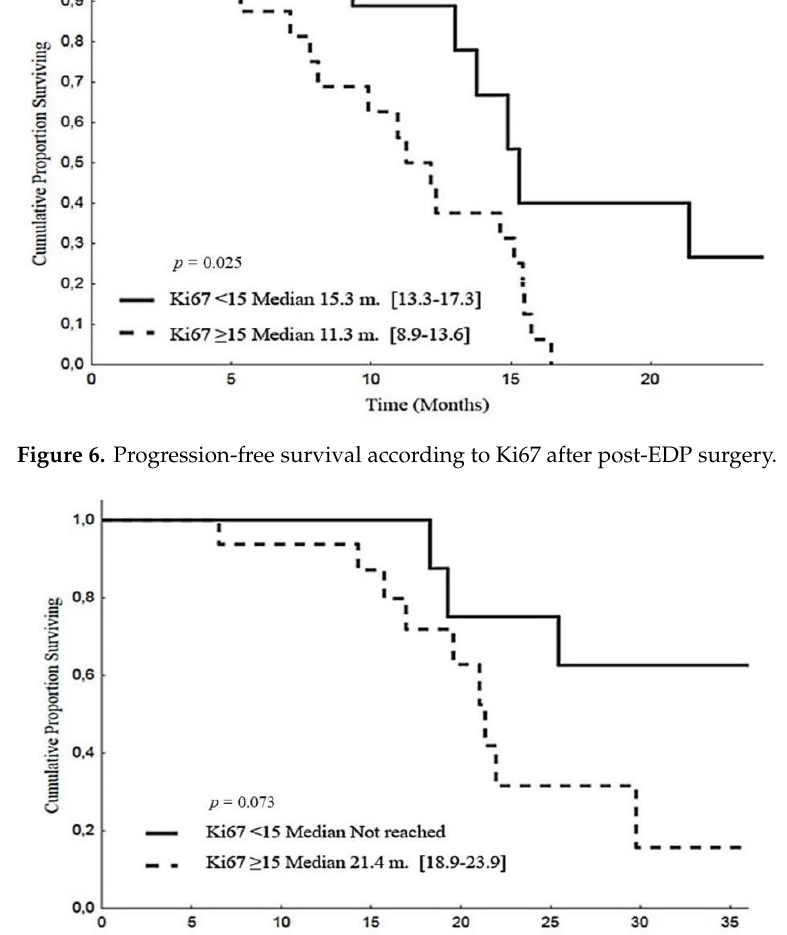
Figure 7. Overall survival according to Ki67 assessed after post-EDP surgery.